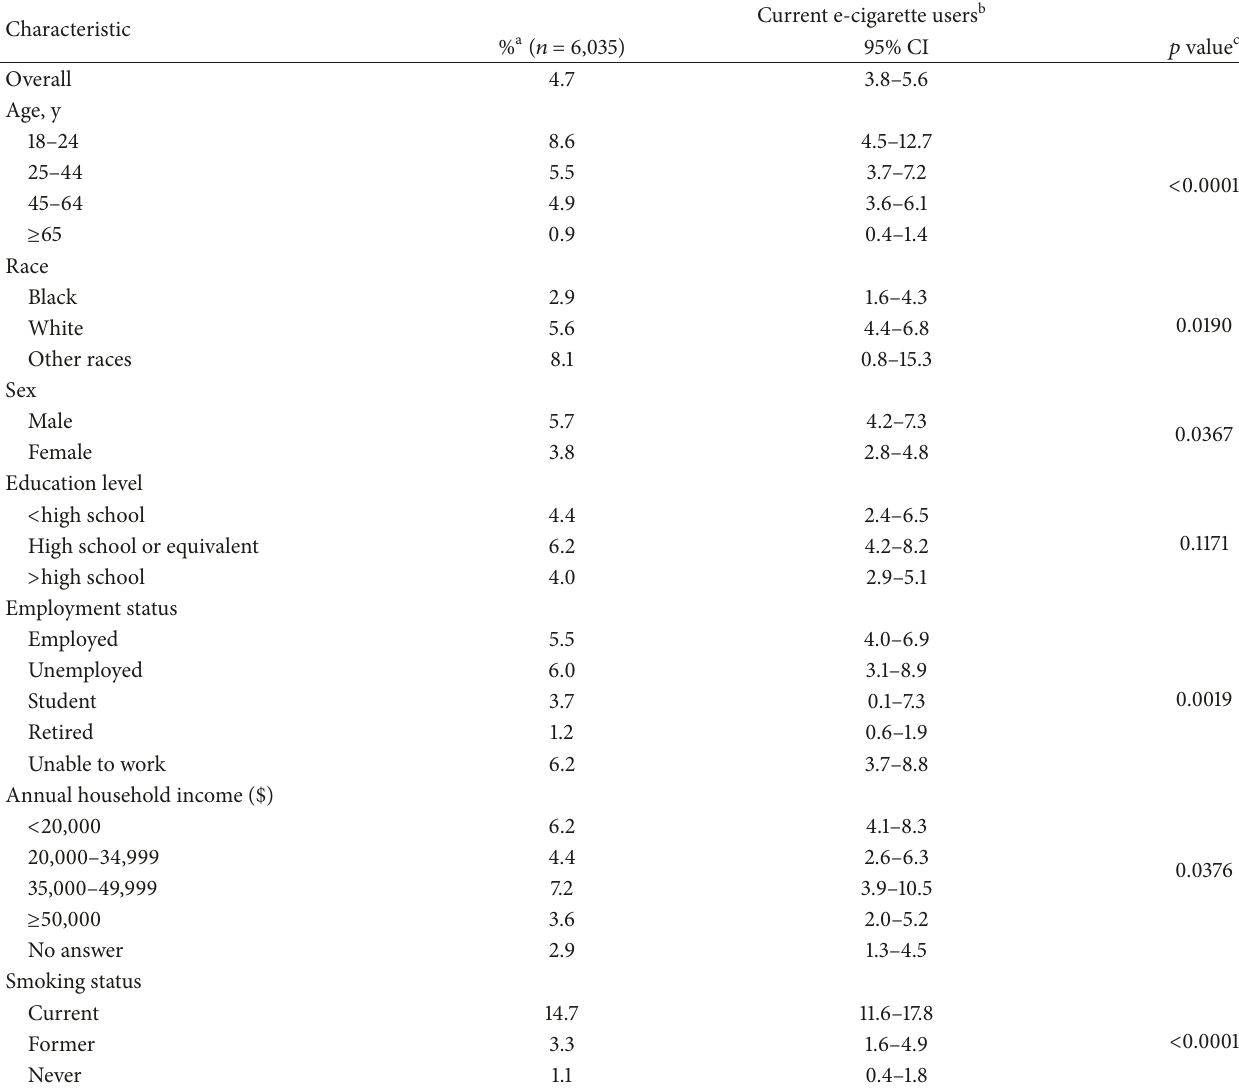
Table 3: Current e-cigarette use among Mississippi adults by sociodemographic characteristics, Behavioral Risk Factor Surveillance System,